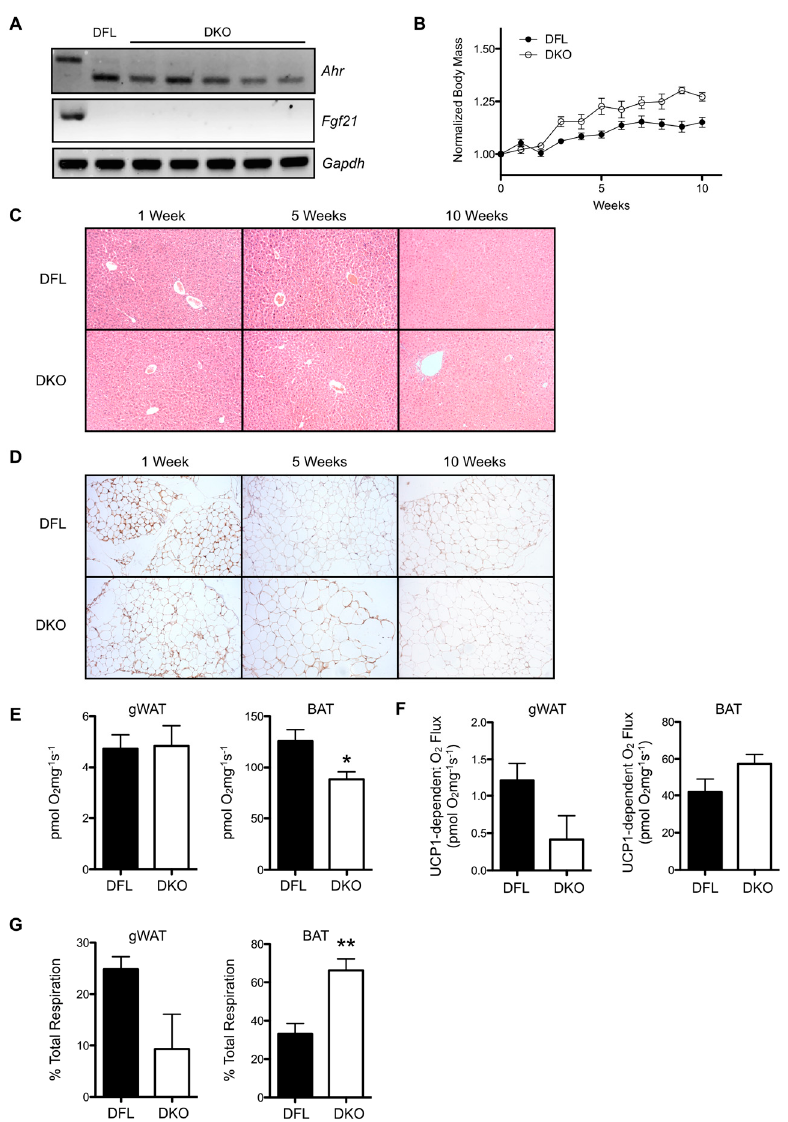
Figure 5. Concomitant loss of AHR and FGF21 reverses the iCKO phenotype. ( A ) Ahr and Fgf21 transcripts are ablated in the livers of inducible, double-conditional AHR-FGF21 knockout mice ( Ahr fl/fl Fgf21 fl/fl Alb-Cre ERT2 , abbreviated “DKO”) 10 weeks after tamoxifen administration ( n = 6). ( B ) DKO mice exhibit greater weight gain over a 10-week period following tamoxifen administration ( n = 5–6 per genotype). ( C ) H&E staining of liver sections from Ahr fl/fl Fgf21 fl/fl (DFL) and DKO mice show comparable liver morphology at 1, 5, and 10 weeks post-tamoxifen treatment. ( D ) UCP1 immunohistochemical staining of gWAT from DFL and DKO mice at 1, 5, and 10 weeks post-tamoxifen